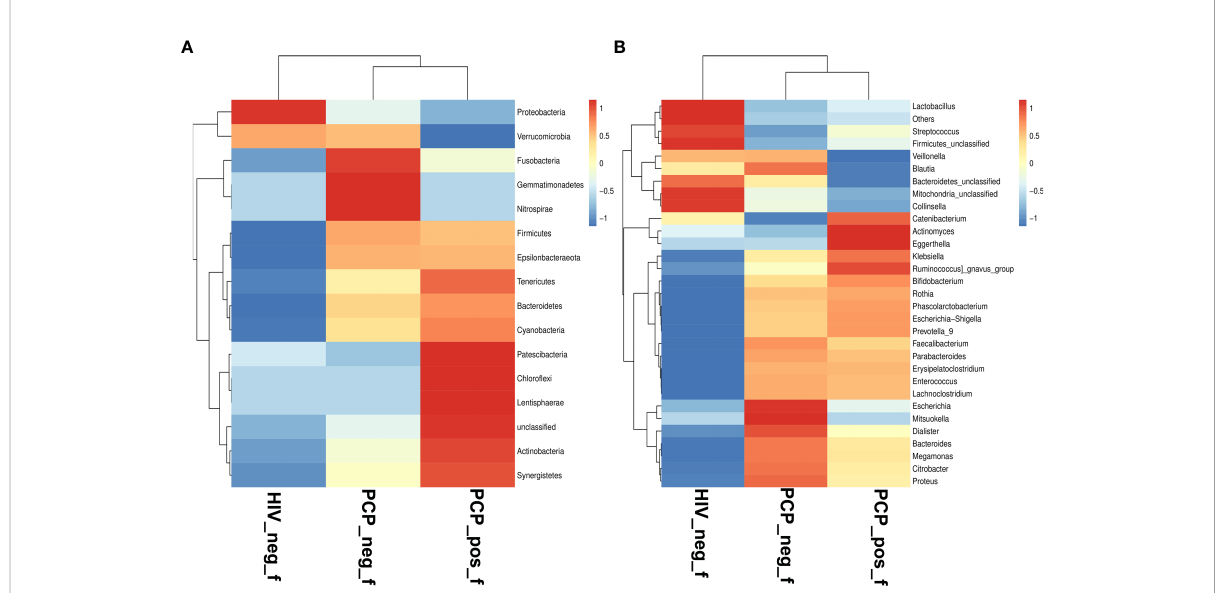
FIGURE 3 Comparison of gut microbiota at phylum and genus levels. (A) Relative abundance of the top 16 phyla in the fecal samples of the HIV+PCP+ (PCP_pos_f), HIV+PCP- (PCP_neg_f), and HIV- groups (HIV_neg_f,.Control). (B) Relative abundance of the top 31 genera in the fecal samples of the HIV+PCP+, HIV+PCP-, and HIV- groups. The gradient color from blue to red re fl ects the change in abundance from low to high.